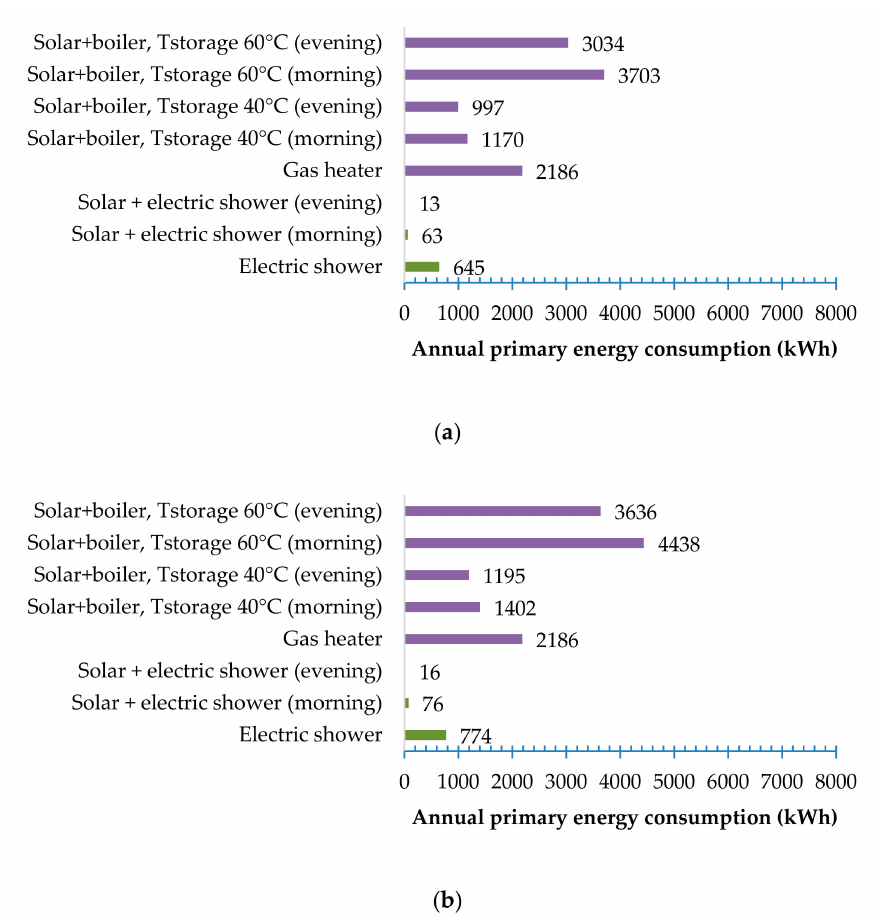
Figure 13. Annual primary energy consumption for water heating in Bel é m. ( a ) Current scenario; ( b ) critical